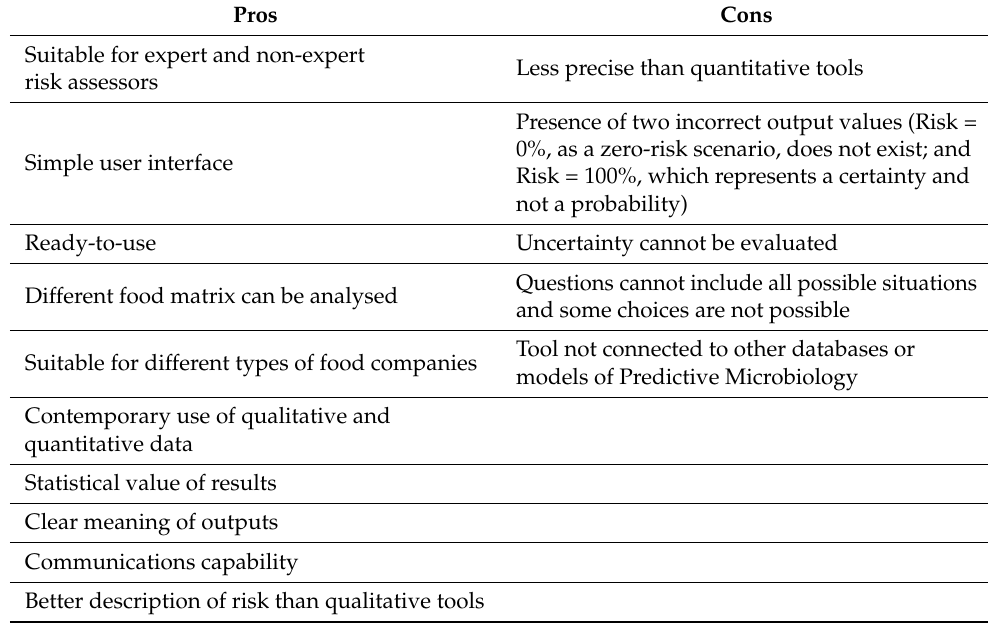
Table 6. Pros and cons of Risk